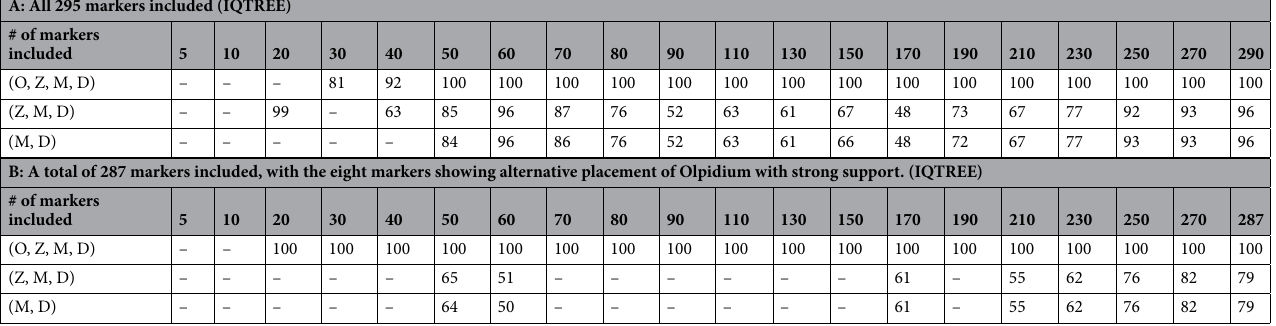
Table 1. Summary of branch support regarding the placement of Olpidium and the main non-flagellated terrestrial fungal groups in RAxML analyses with the markers added sequentially according to their informativeness. For each dataset, we performed RAxML analysis with 100 bootstrap replicates and PROTGAMMALG model. The arrangement of (O, (Z, (M, D))) was recovered in all the RAxML